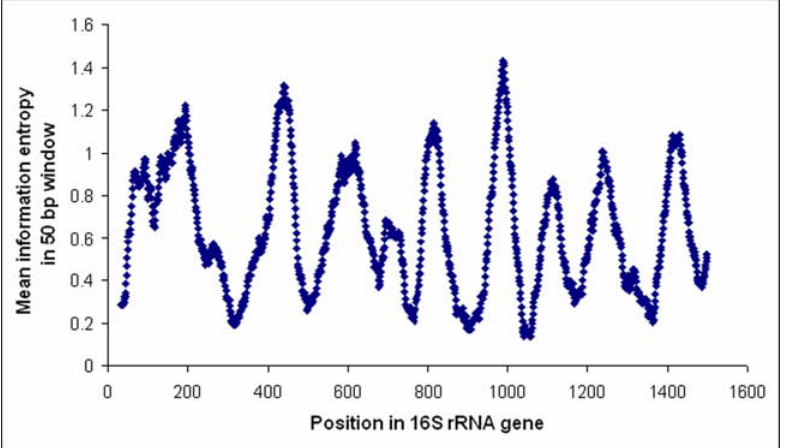
Figure 1. Variability within the 16S rRNA gene. From pre-aligned sequenced . 1200 bp downloaded from RDP, the variability, measured as Shannon information entropy, was calculated at each sequence position, using only positions without a gap in E. coli. The graph shows the Shannon entropy (y-axis) averaged over 50 bp windows, centered at each position in the gene (x-axis). Shannon entropy at position x was calculated as – S p ( x i ) log 2 p ( x i ), where p ( x i ) denotes the frequency of nucleotide i . The filled arrows indicate positions of the PCR primers, the dashed arrow the direction of sequencing.